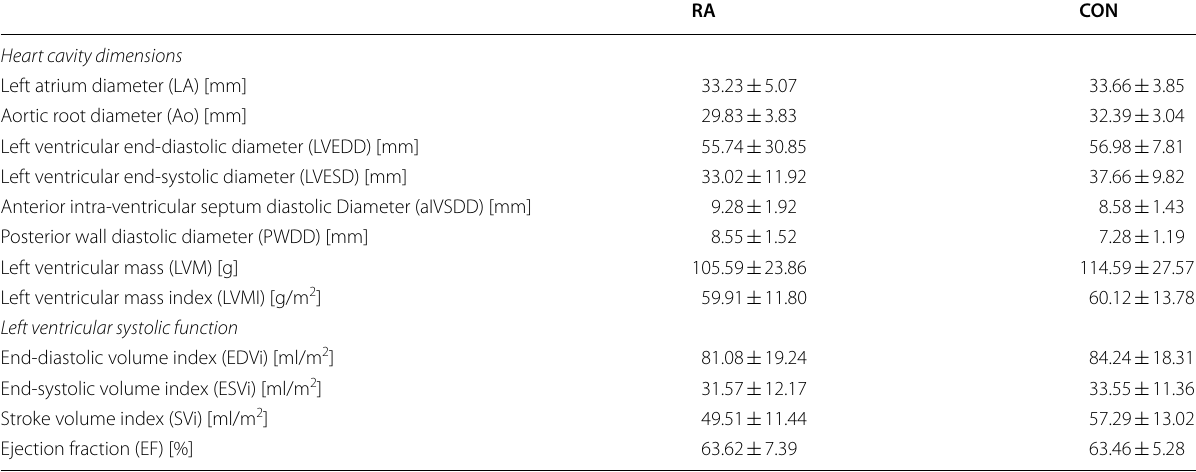
No statistical differences between the studied groups